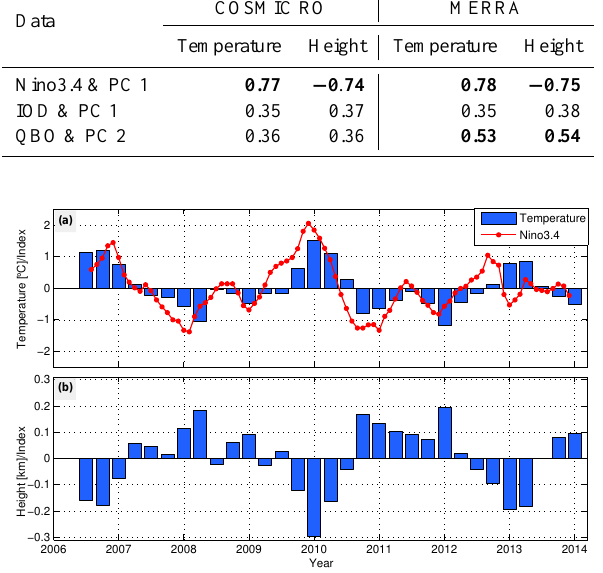
Figure 13. Seasonal mean tropopause temperature and height anomalies due to ENSO mode together with the Niño3.4 index. The area-averaged time series were obtained by multiplying EOF 1 and PC 1, i.e., basically showed the replication of ENSO